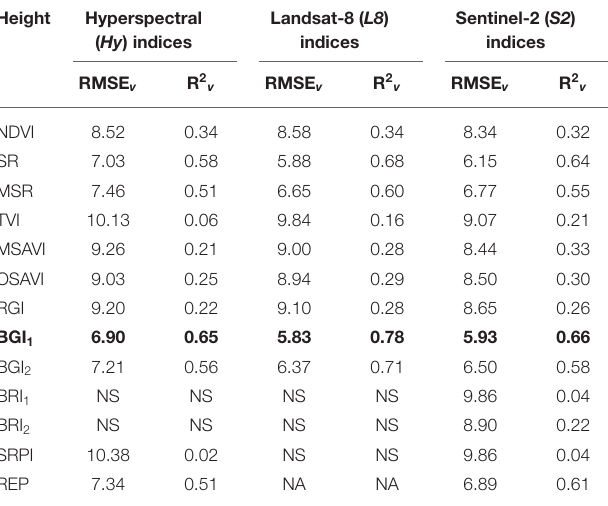
TABLE 6 | Validation statistics (RMSE v and R 2 v ) of simple linear regression models of Hyperspectral ( Hy ) indices, and synthesized Landsat-8 ( L8 ) and Sentinel-2 ( S2 ) indices obtained for canopy cover of finger millet.